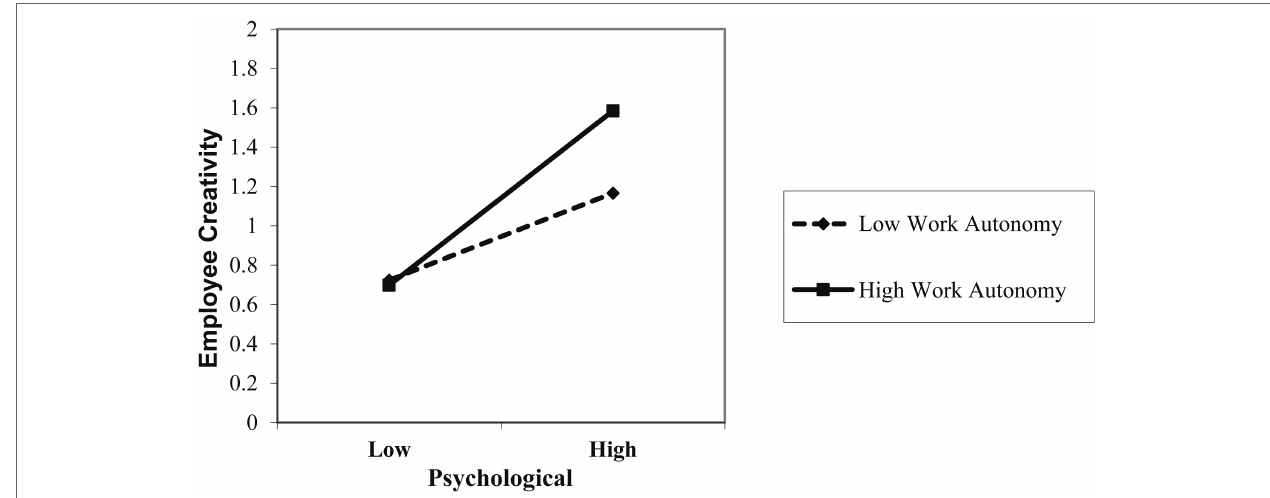
FIGURE 2 | Moderation effect of work